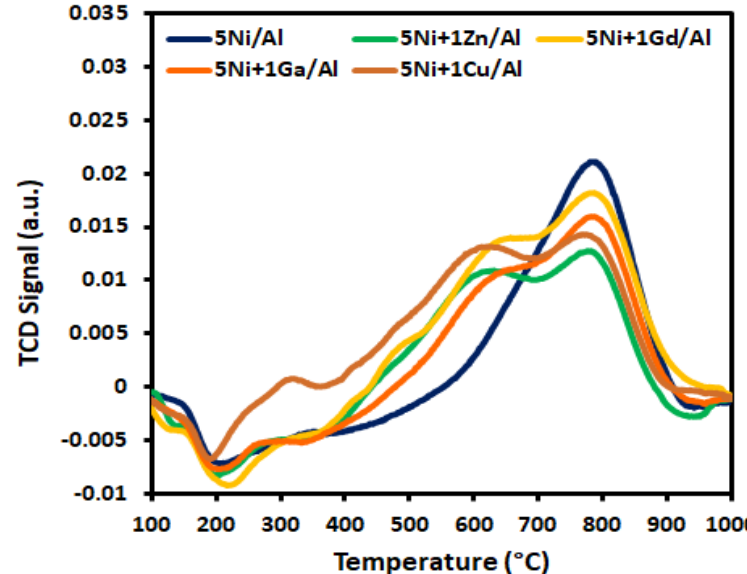
Figure 2. Temperature-programmed reduction (TPR) profiles of the non-promoted and promoted catalysts.